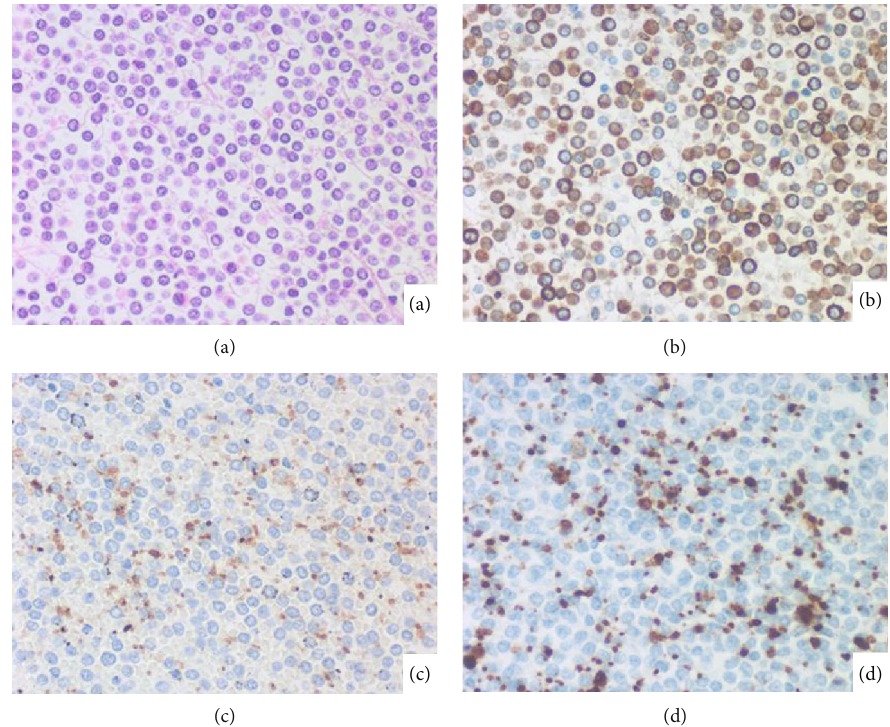
Figure 2: Histopathological appearance of blood clot in the atrium ((a) H&E; immunostaining for MPO (b), CD42b (c), and CD61 (d)). Most of the small-sized blastic cells in the blood express MPO. CD42b and CD61 label platelets among the blasts, but the blasts are devoid of expression of the megakaryocytic